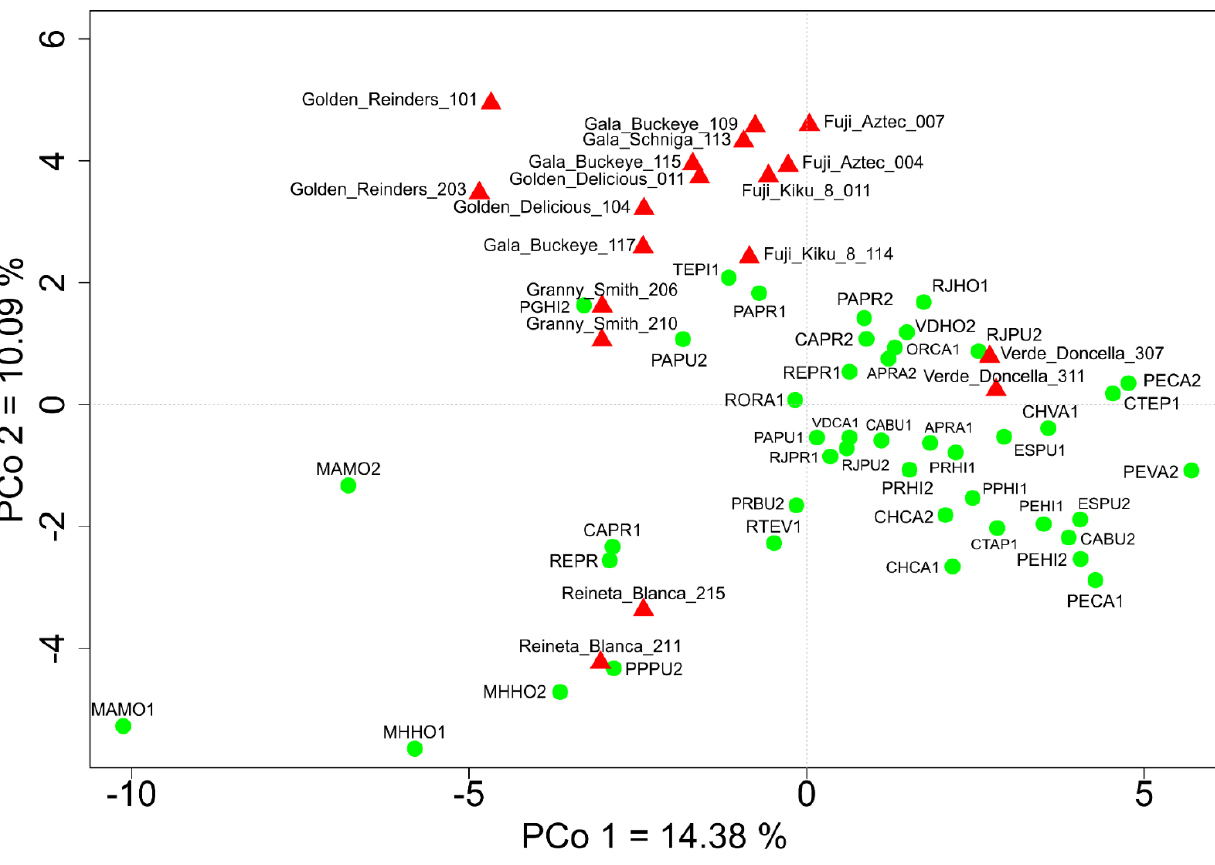
Figure 4. Plot between PCo 1 and PCo 2 for all 67 old apple cultivar individuals and 18 reference individuals from ‘Fuji’, ‘Gala’, ‘Golden’, Granny Smith’, ‘Reineta Blanca’ and ‘Verde Doncella’ based on morphological descriptors. Red triangles, reference cultivars; green circles, old apple